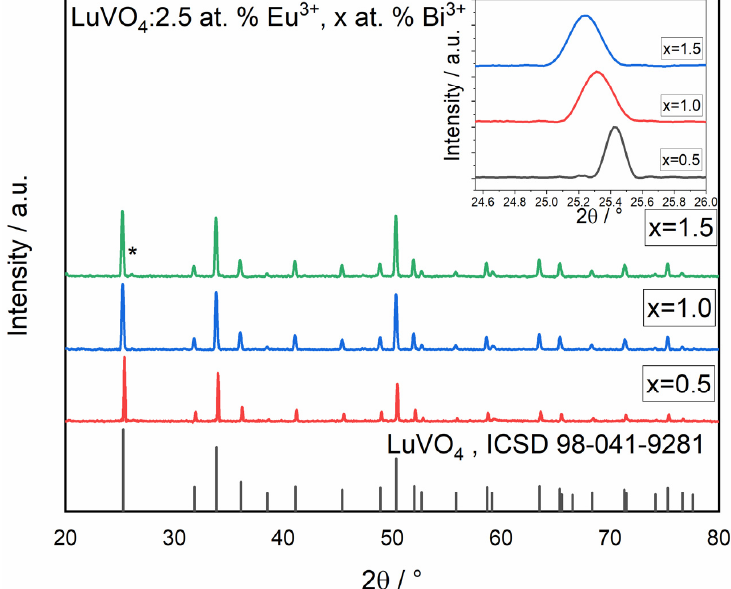
Figure 2. The XRD patterns of LuVO 4 : 2.5 at. % Eu 3+ , X at. % Bi 3+ (X = 0.5, 1, 1.5) powders prepared from the same sol of the films. The inset is the partial magnification of the (200) peak. On X= 1.5 sample, at ≈ 26.05° (*) the secondary phase LuVO 3 it’s observed.